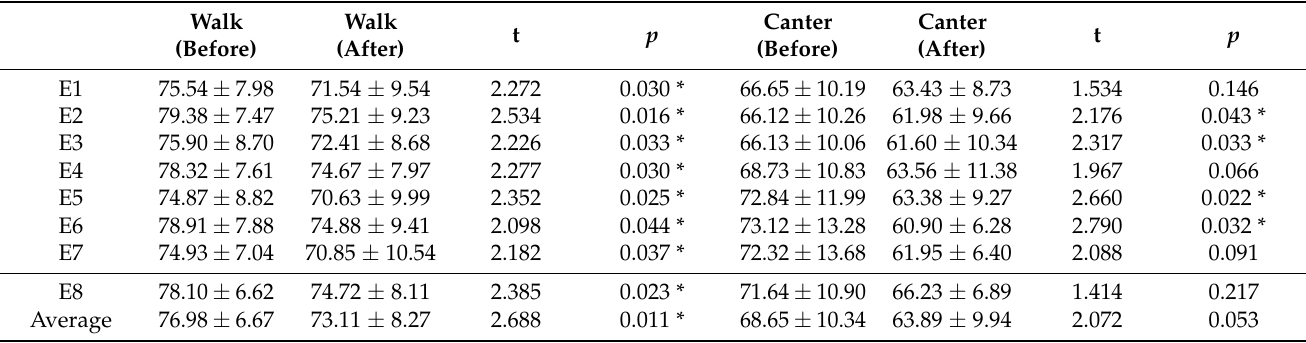
Table 4. Head–neck angles. Unit: degrees.